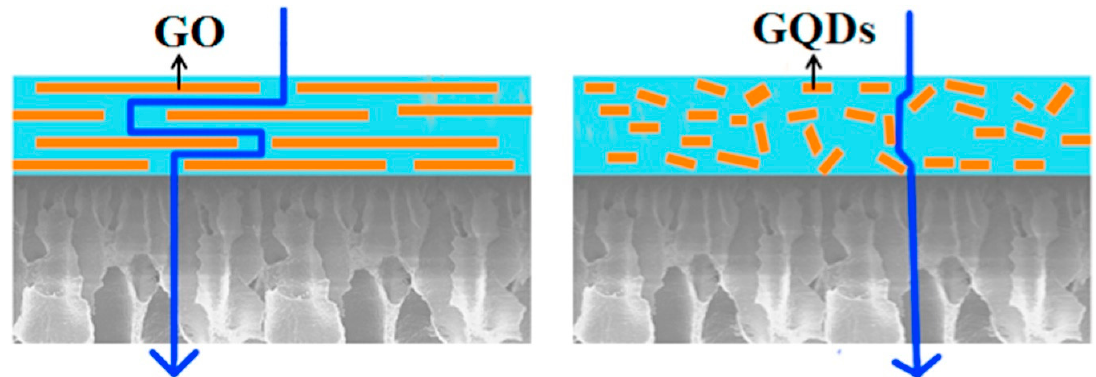
Figure 3. Schematic depiction of water permeation in nanocomposite PEG@POSS-SA membrane. Taken from Wang et al. [48].